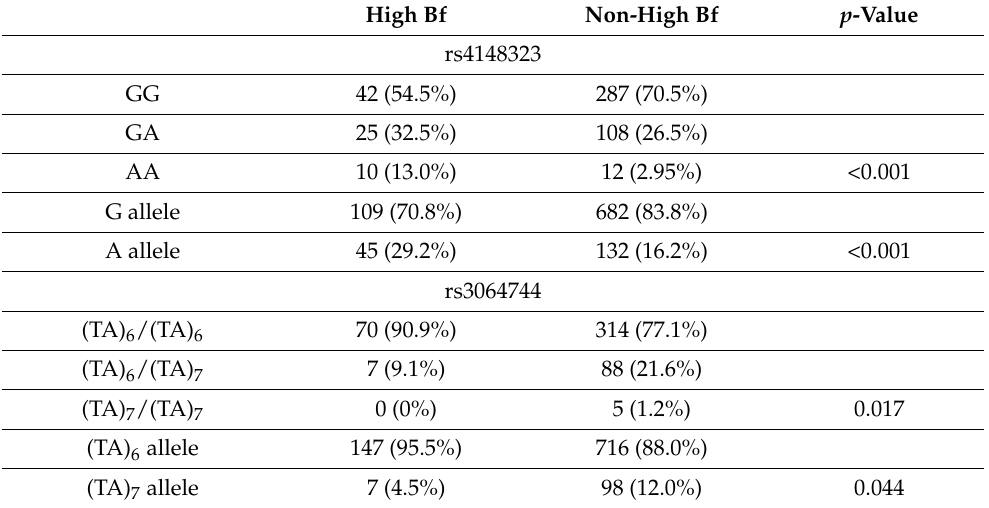
Table 2. Genotype and Allele Counts.